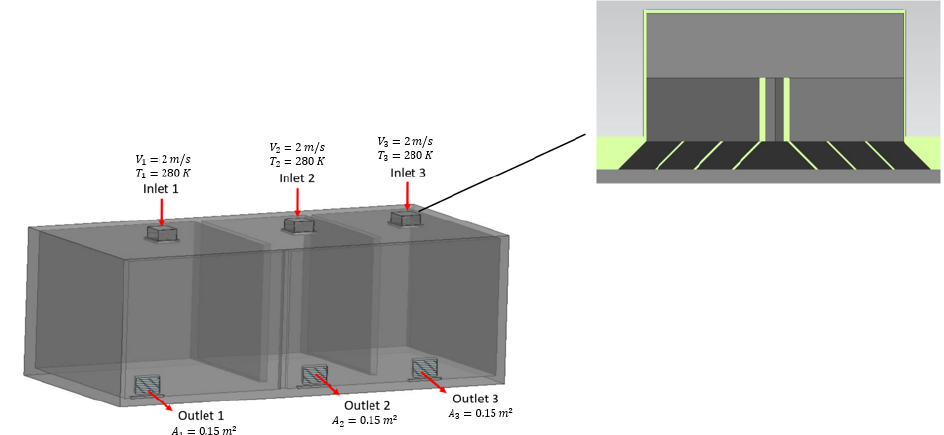
Figure 4. 3D view of the simulation domain added by inlets and outlets. The air inlet duct (ceiling diffuser) is shown in detail from the vertical cross section whose grilles conduct the flow at 45 degrees. Source: prepared by the authors.